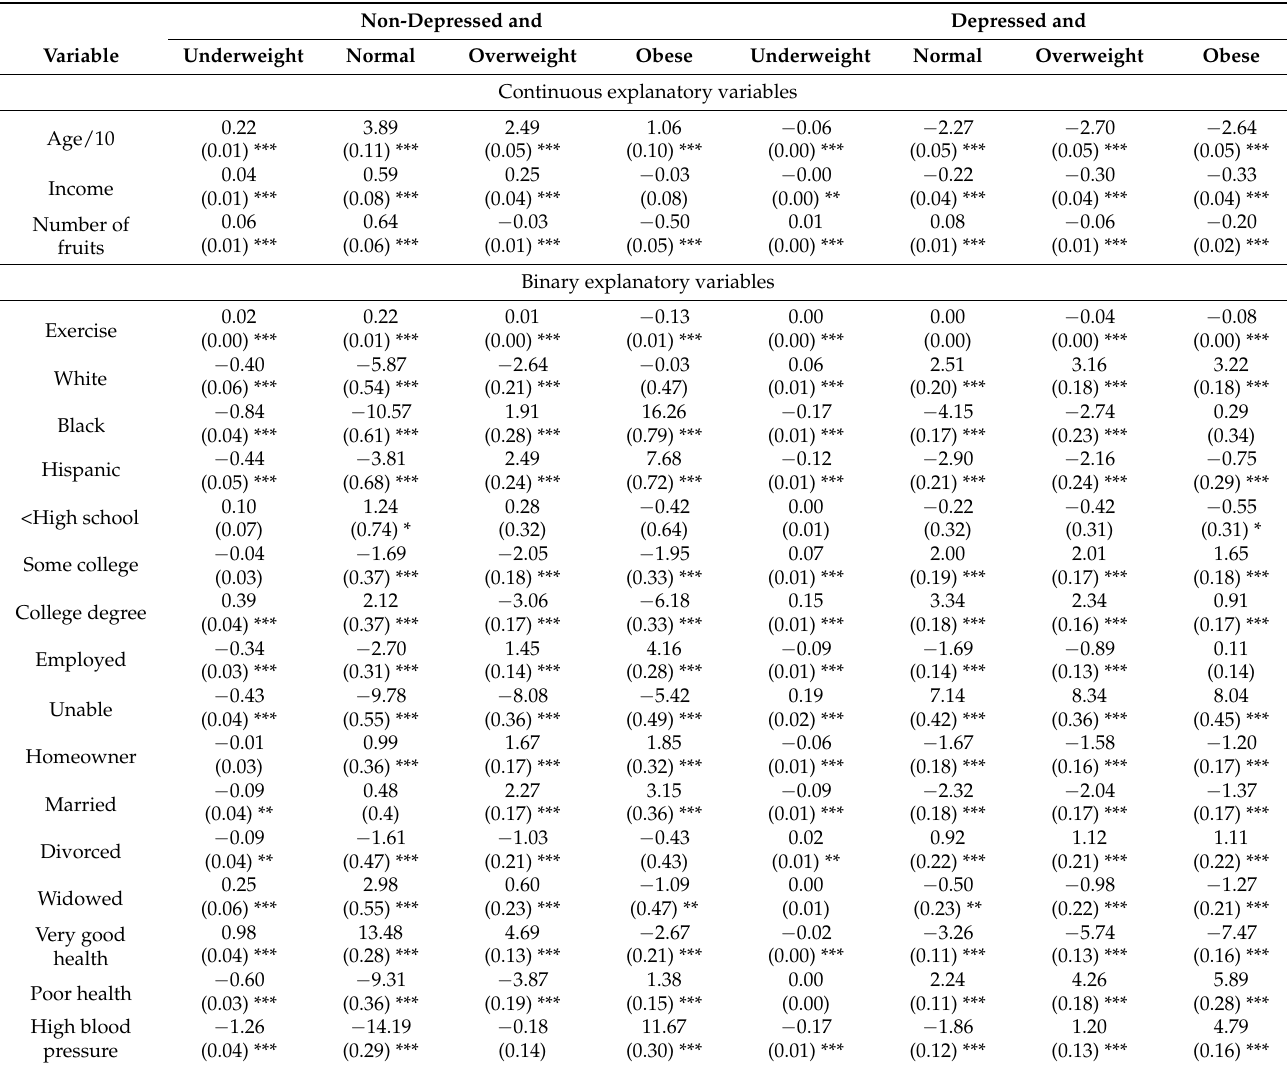
Table 4. Marginal effects of explanatory variables on the joint probability of depression and body weight categories for female